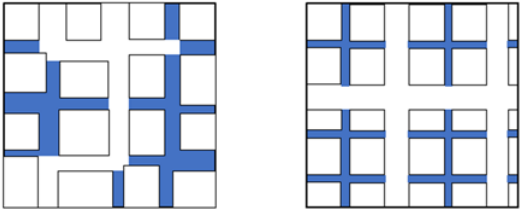
Figure 3. Different saturations for constant porosity and constant mean throat diameter but different organization of the pore network (PN). Solid and empty pores and throats in white and liquid saturated pores and throats in blue.